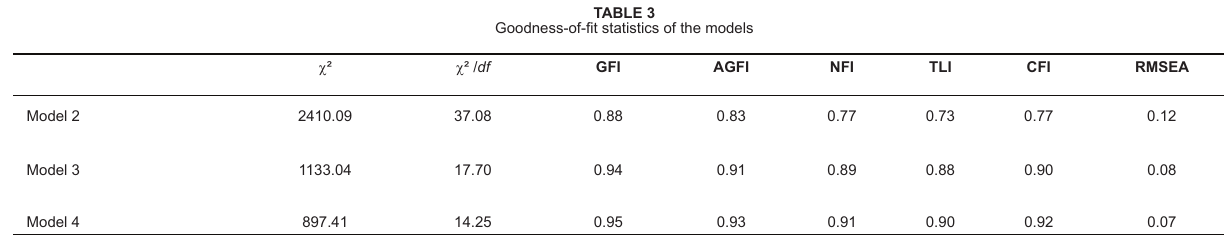
TABLE 3 Goodness-of-fit statistics of the models